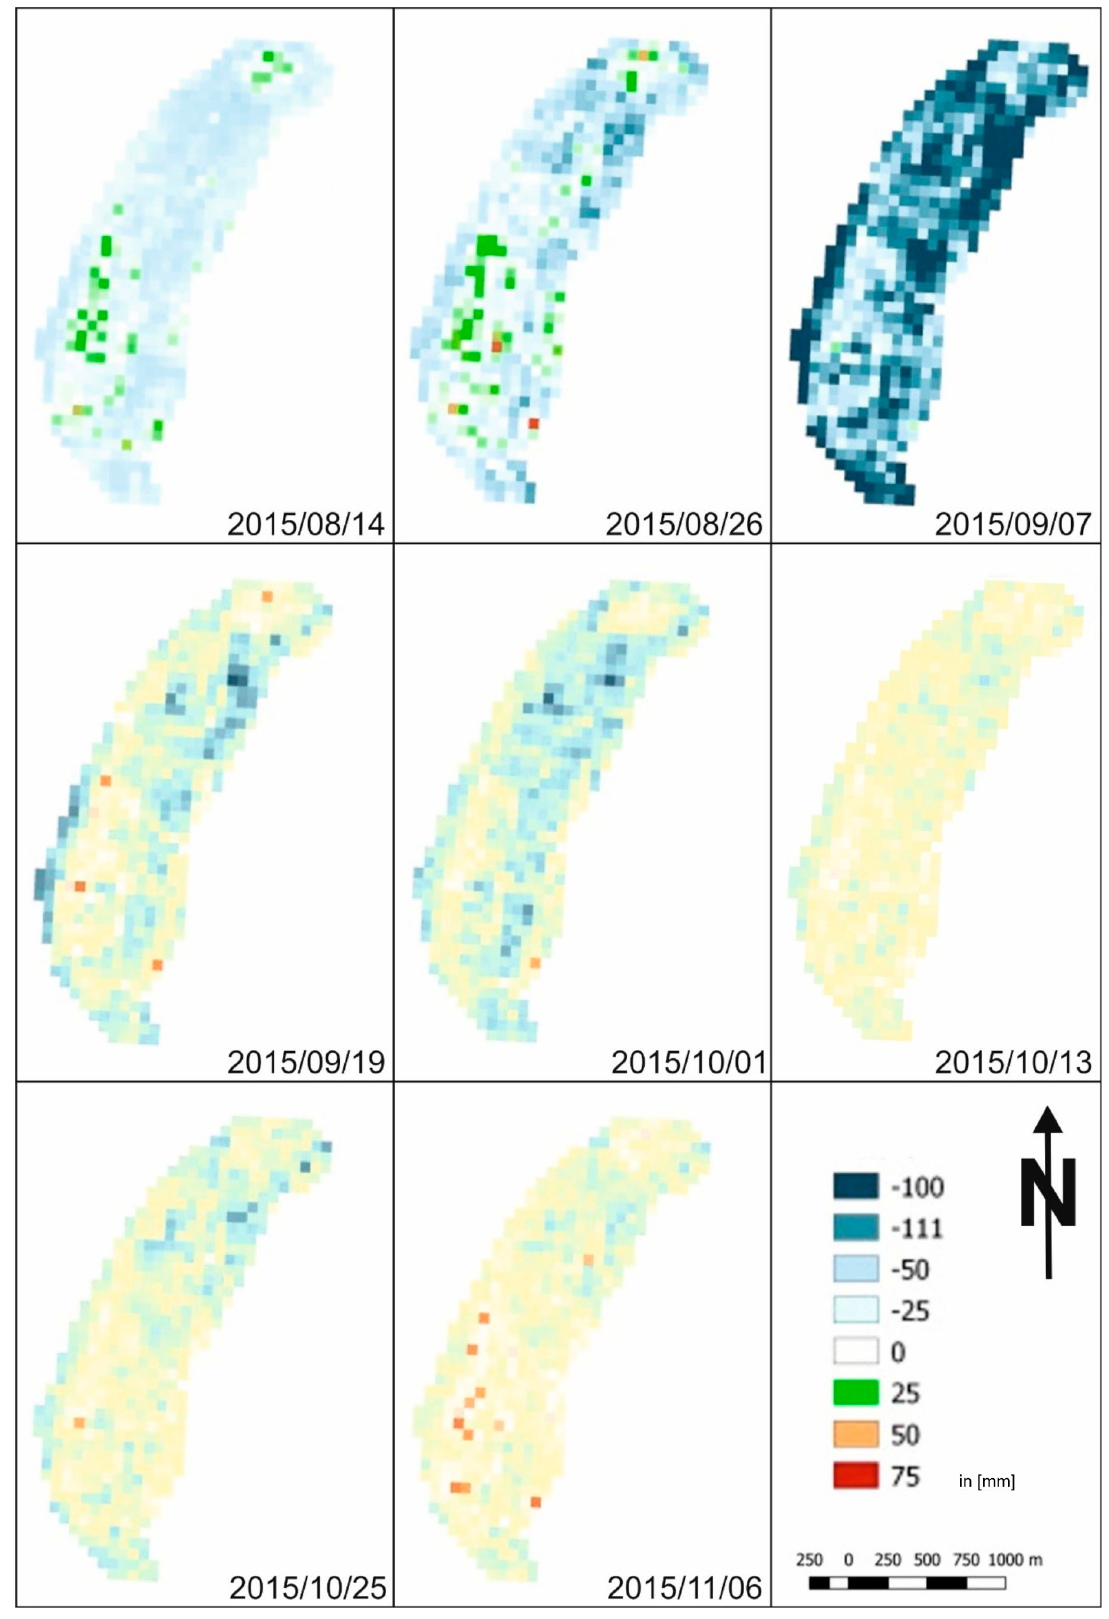
Figure 7. Time series representing the shape changes of the end moraine of the Werenskiold Glacier between 2 August and 6 November, 2015. The first image (upper left) is the reference model.